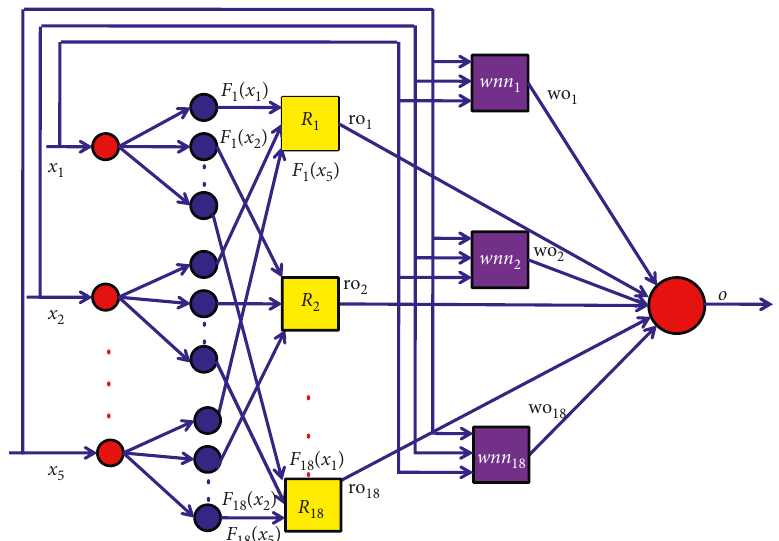
Figure 2: Schematic structure of FWNN models.